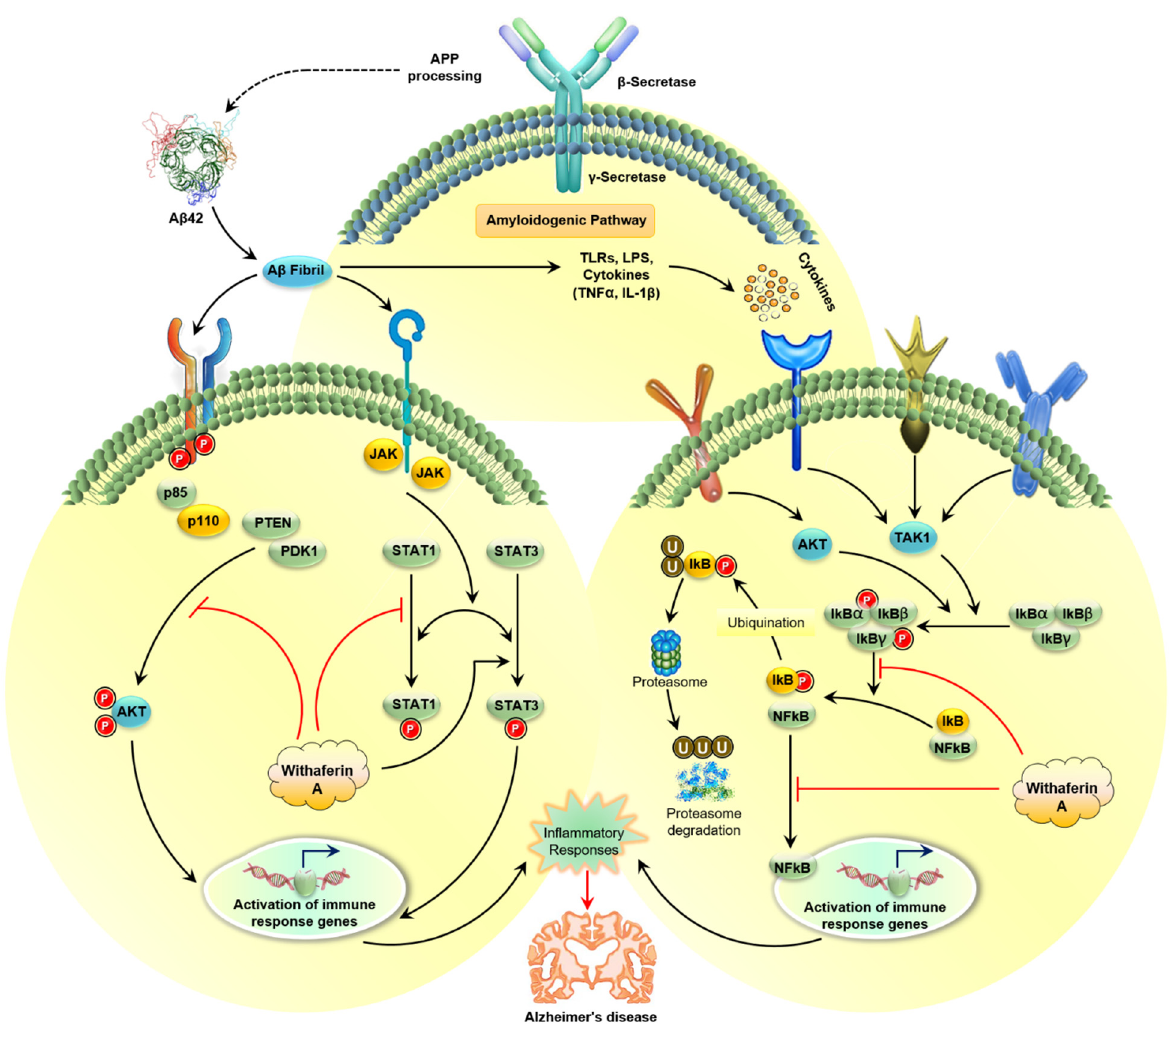
Figure 2. Schematic representation showing the target sites of WA action in amyloidogenic pathway that leads to AD. WA inhibits NF- κ B signaling (right side). WA regulates several kinase-signaling pathways such as AKT and JAK/STAT. Abbreviations: APP: amyloid precursor protein; A β : β -amyloid; TLR: Toll-like receptor; LPS: lipopolysaccharides; IKK: I κ B kinase; TNF- α : tumor necrosis factor- α ; IL-1 β : interleukin-1 β ; MAP3K7)/TAK1: mitogen-activated protein kinase 7 (MAP3K7)/(TAK1); NF- κ B: nuclear factor kappa B; U: ubiquinone; JAK: Janus kinase; STAT: signal transducers and activators of transcription; PTEN: phosphatase and tensin homolog; PDK1: phosphoinositide-dependent kinase-1; AD: Alzheimer disease; WA: withaferin A.